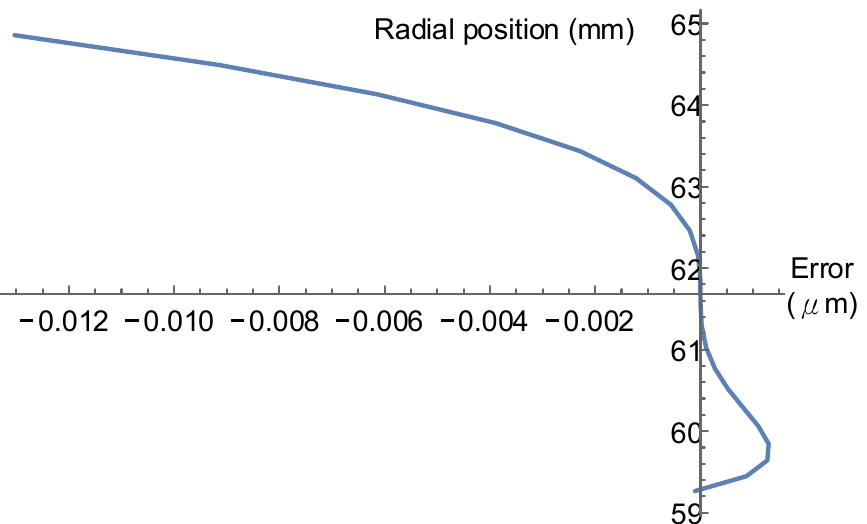
Figure 12. Cutter edge profile error of curvature and the third-order corrected case of the cutter face, with ξ = 0.